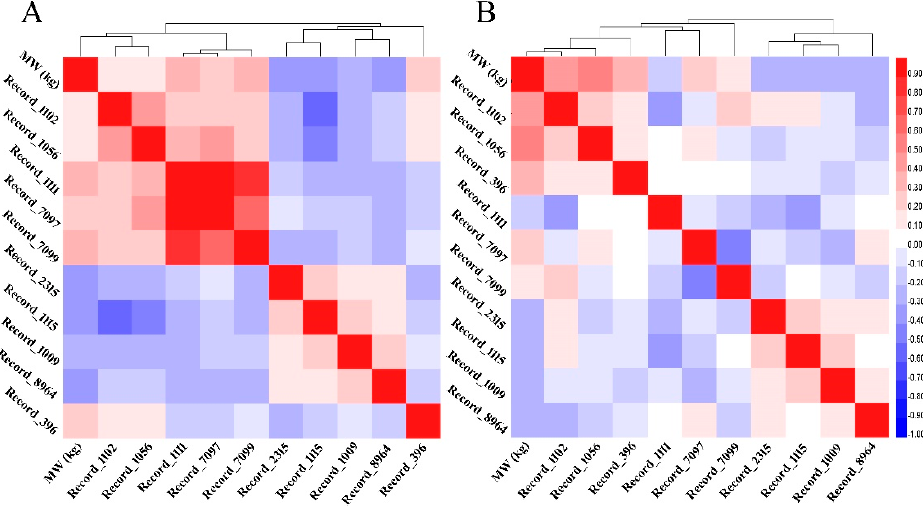
Figure 5. ( A ) Heat map with clustering analyses showing the pairwise Spearman correlations between all SNPs and marketing weight of males from the first and ( B ) second populations.